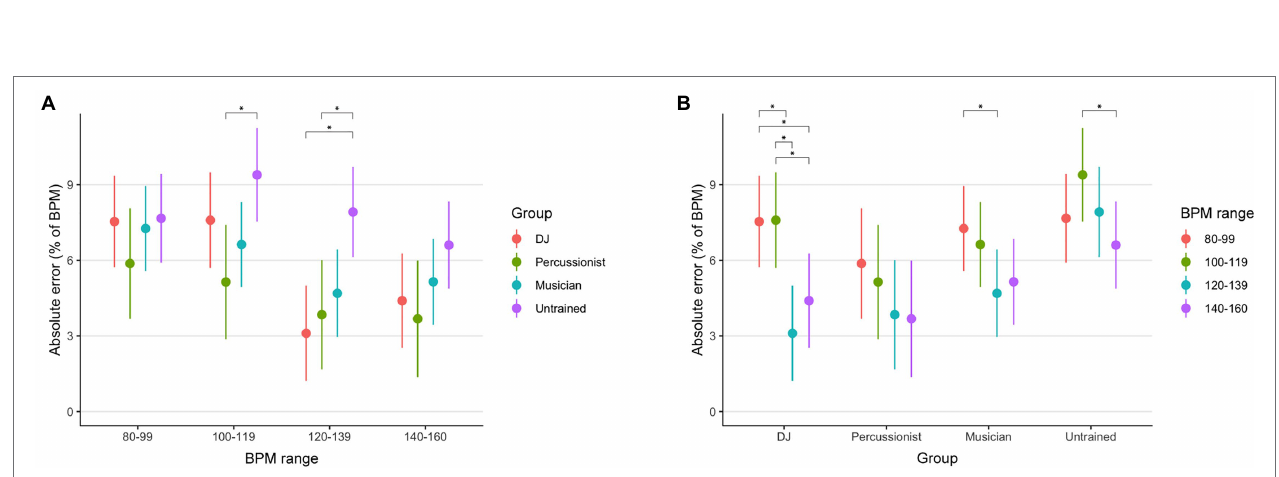
FIGURE 2 | Mean accuracy of tempo judgments by participant group and tempo range. In panel (A) , the values are organized by group, and Sidak-corrected significance of pairwise differences between tempo ranges within groups is indicated. In panel (B) , values are organized by tempo range and Sidak-corrected significance of pairwise differences between groups is indicated. Error bars indicate 95% confidence intervals of the estimated marginal